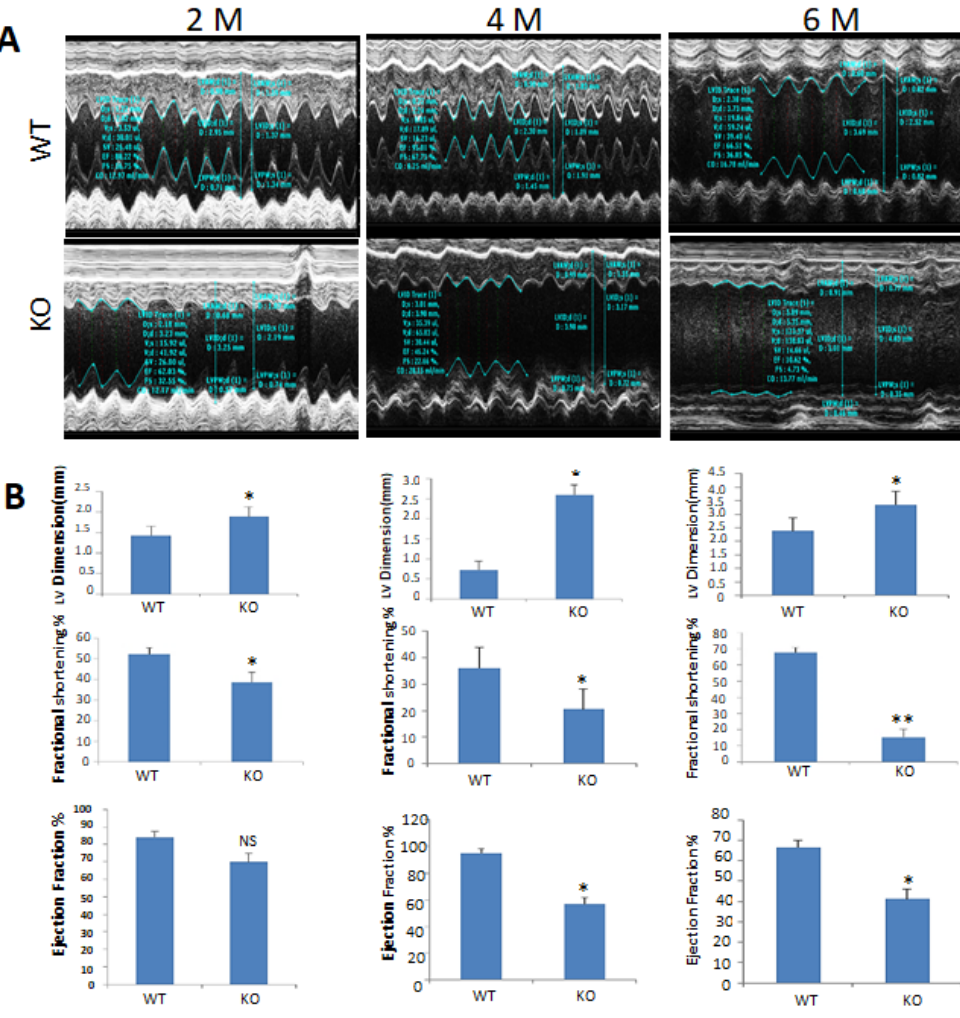
Echocardiographic results showing poor contractility of csPIMT − / − hearts. ( A ) Representative profiles of M-mode echocardiographic analyses of 2-, 4-, and 6-month-old PIMT fl/fl (WT, upper panel) and csPIMT − / − (KO, lower panel) mice; ( B ) Quantification of left ventricular dimension (upper panel), and fractional shortening (middle panel) and ejection fraction (lower panel) are shown below for 2-, 4-, and 6-month PIMT fl/fl and csPIMT − / − echocardiographic images. Values were expressed as the mean ± SD. * p < 0.05, ** p < 0.01, NS: not significant.